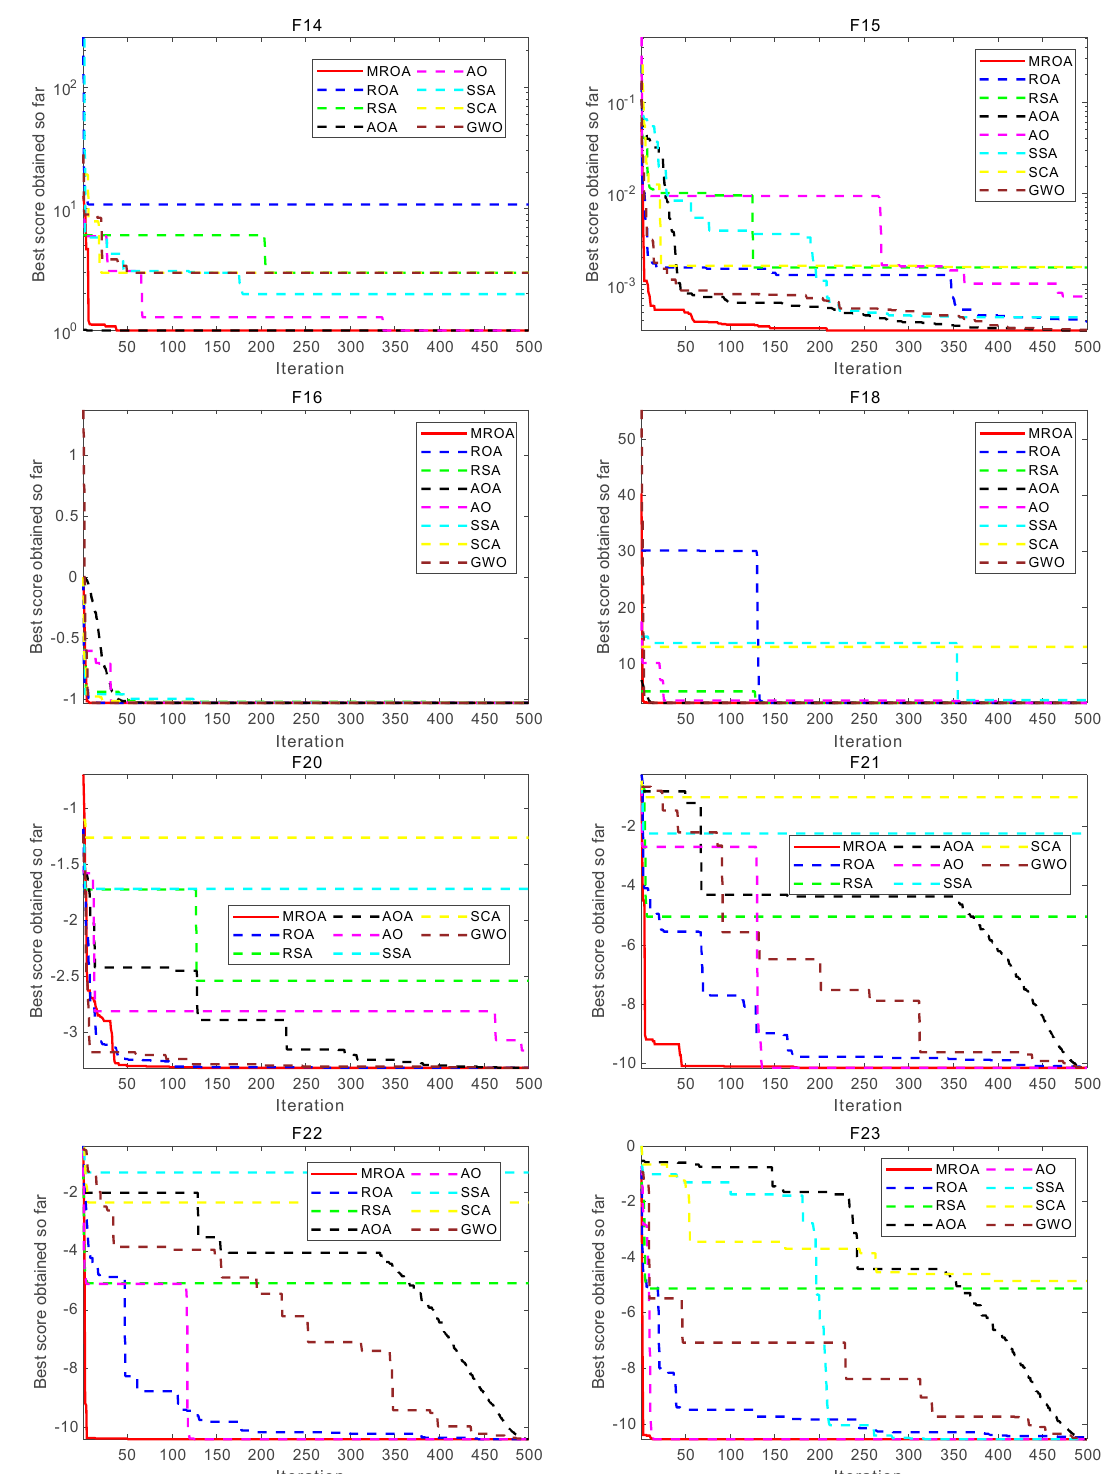
Figure 8. Convergence behavior of algorithms on some functions.